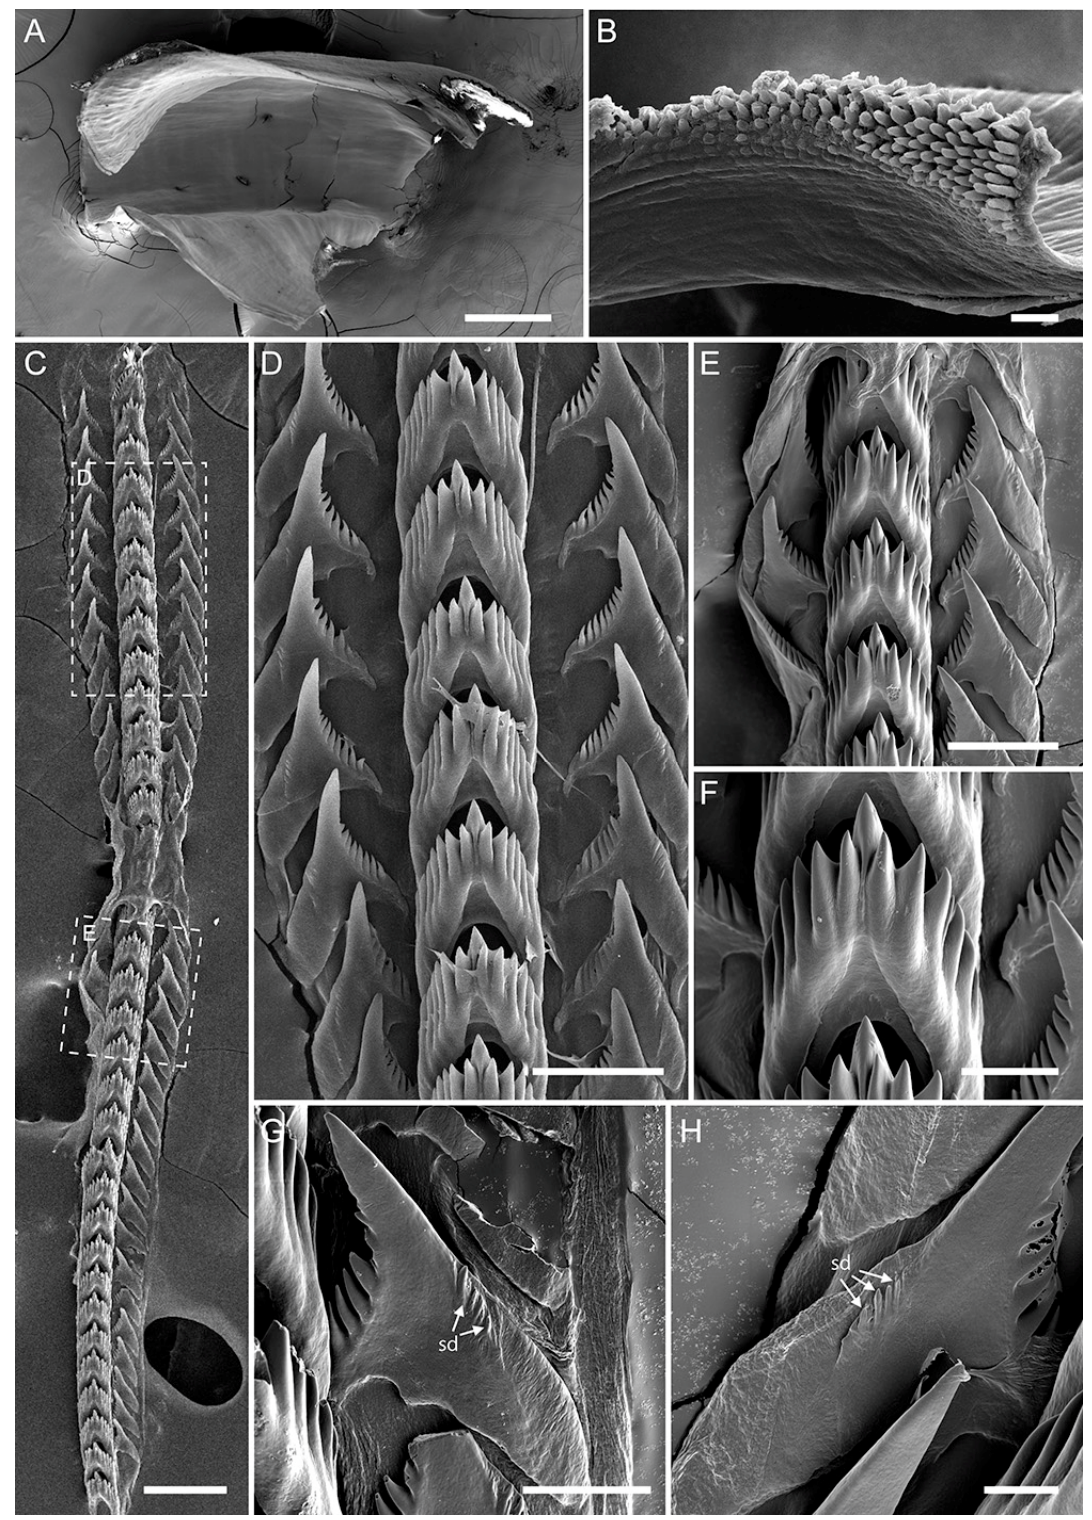
Figure 13. Coryphellina aurora sp. nov. , holotype ZIN63224, buccal armature. ( A )—left jaw plate. ( B )—denticulation of masticatory process. ( C )—radula. ( D )—posterior radular portion. ( E )—middle radular portion. ( F )—rachidian tooth. ( G )—lateral tooth. ( H )—lateral tooth. Abbreviations: sd—secondary denticles on outer side of lateral tooth. Scale bars: ( A , C ) = 200 μ m; ( B , E ) = 20 μ m; ( D , F ) = 50 μ m; ( G , H ) = 30 μ m.